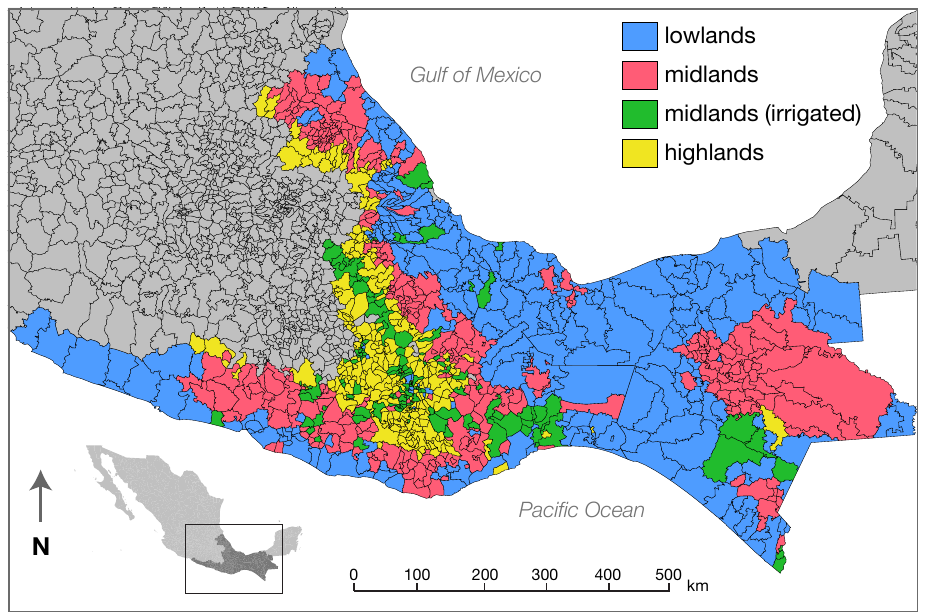
Figure 2. Mexican municipalities in the study area colored by farm type clusters